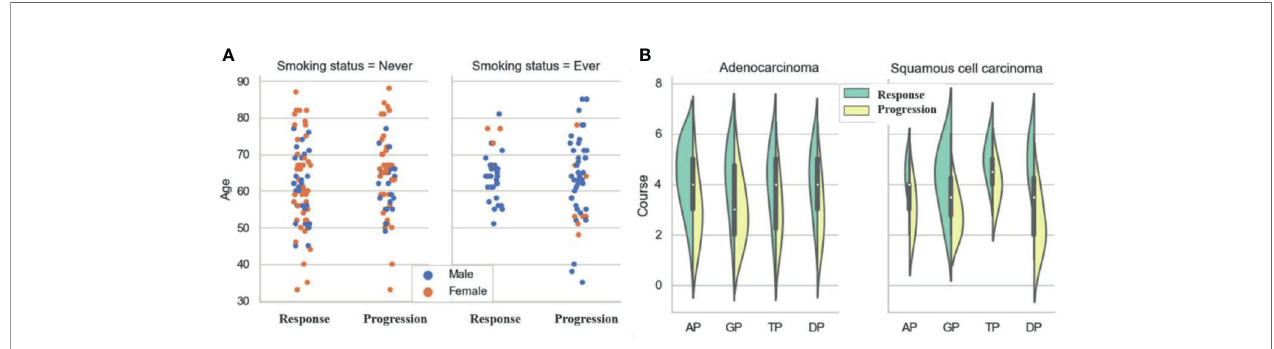
FIGURE 3 | Analysis of clinical characteristics: (A) Statistics of ages, genders and smoking status; (B) Statistics of treatment courses and chemotherapy